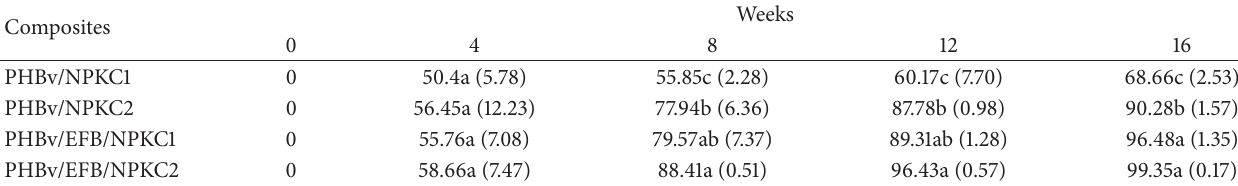
Table 4: Weight loss of bioplastic fertilizer (BpF) composites from soil burial test.